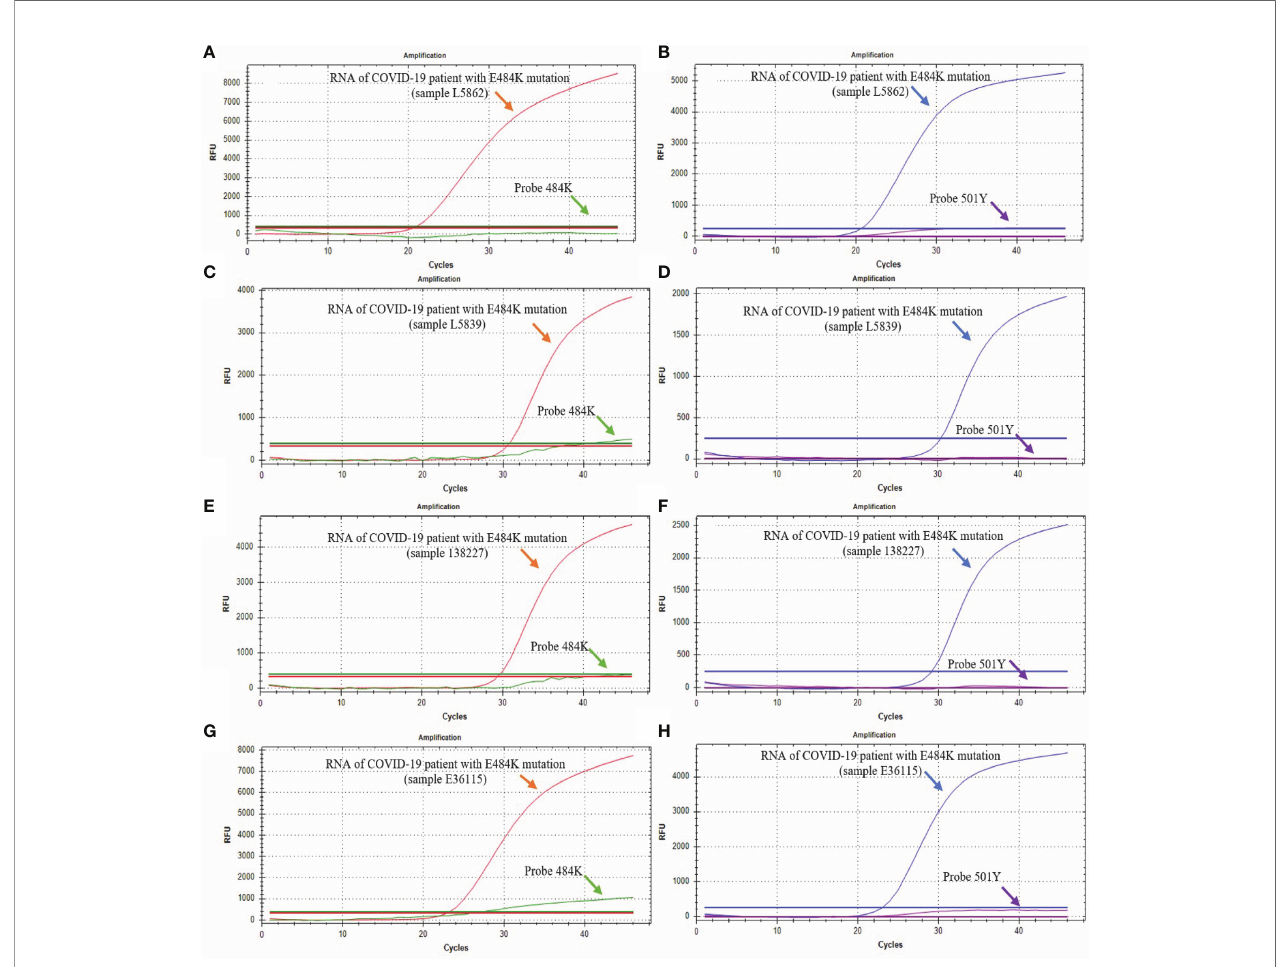
FIGURE 5 | Detection of E484K and N501Y mutations. The green curve corresponds to the probe that detects the sequence without the E484K mutation (Probe 484E); the red curve corresponds to the probe that detects the sequence with the E484K mutation (Probe 484K); the blue curve corresponds to the probe that detects the sequence without the N501Y mutation, and the purple curve corresponds to the probe that detects the sequence with the N501Y mutation. (A, B) show the results from the L5862 patient; (C, D) show the results from the L5039 patient; (E, F) show the results from the 138227 patient; (G, H) show the results from the E36115